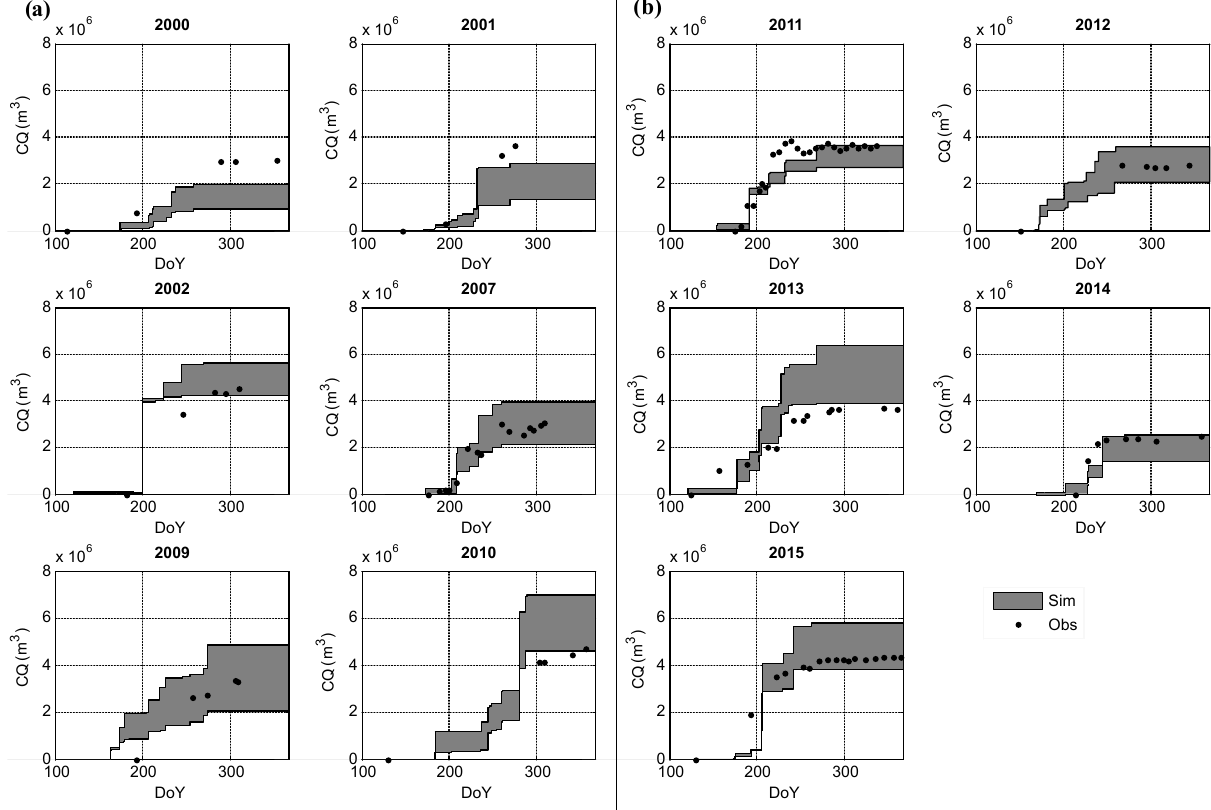
Figure 5. Cumulative discharge (CQ) for years with observation data over 2000–2015. For each year, black dots are for the observations and the gray-shaded envelope represents the maximum and minimum of the 10 members of the ensemble simulations. Panel (a) is for the validation period and panel (b) is for the channel set-up period.